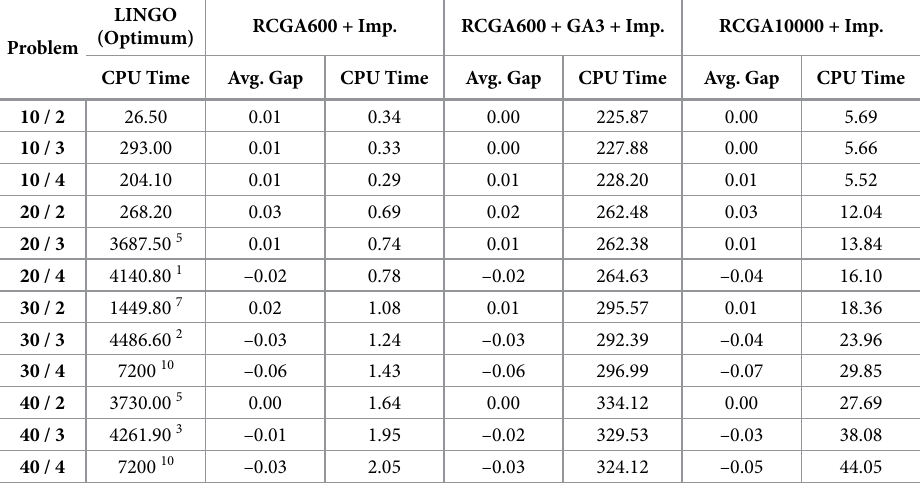
Table 4. Performance of